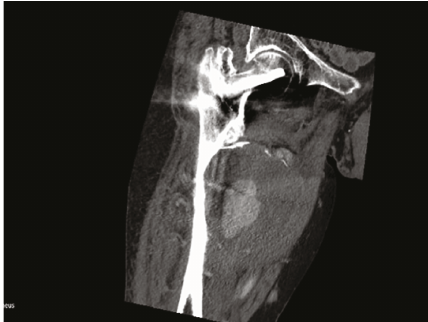
Figure 4: Contrast-enhanced computed tomography (CT) with IV contrast showed an active extravasation in the hematoma which concluded to the diagnosis of pseudoaneurysm. Severe scalloping of the medial femoral cortex was con fi rmed.